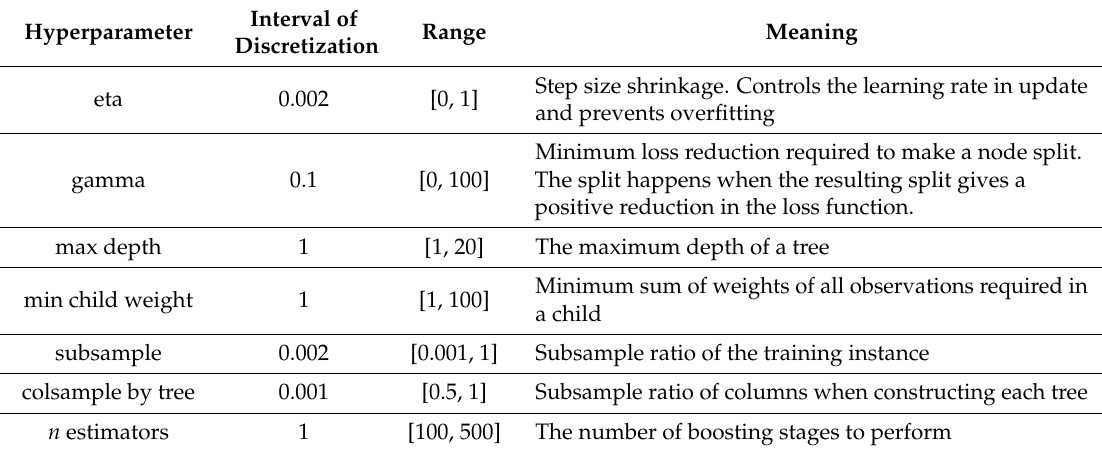
Table 6. Content of chromosome for optimizing the values of hyperparameters of XGBoost.